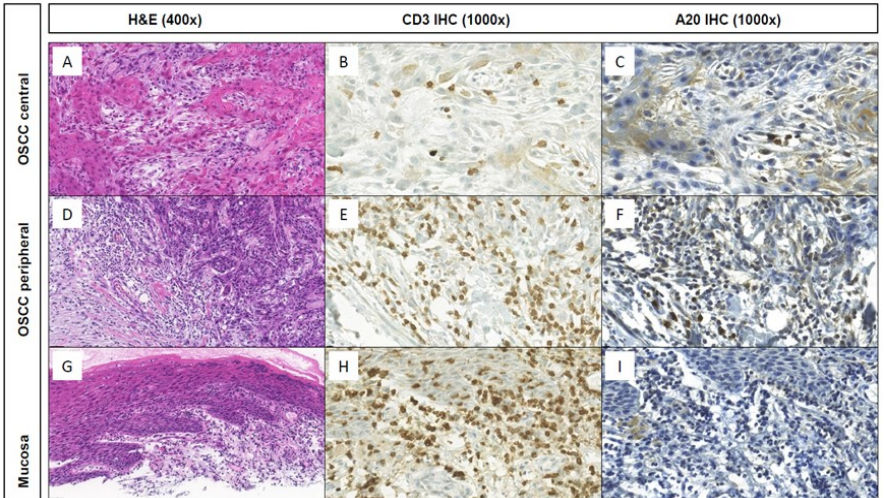
Figure 1. Histomorphology (H&E; ( A , D , G )) and CD3 and A20 IHC stainings at central and peripheral tumor areas and the associated non-neoplastic mucosa of a representative keratinizing OSCC case of the TMA cohort. Whereas only few or no stromal CD3+ T cells within the tumor center ( B , C ) and non-neoplastic mucosa ( H , I ), respectively, show A20 IHC expression, high A20 expression was observed within the stromal CD3+ T cells at the tumor periphery ( E , F ).